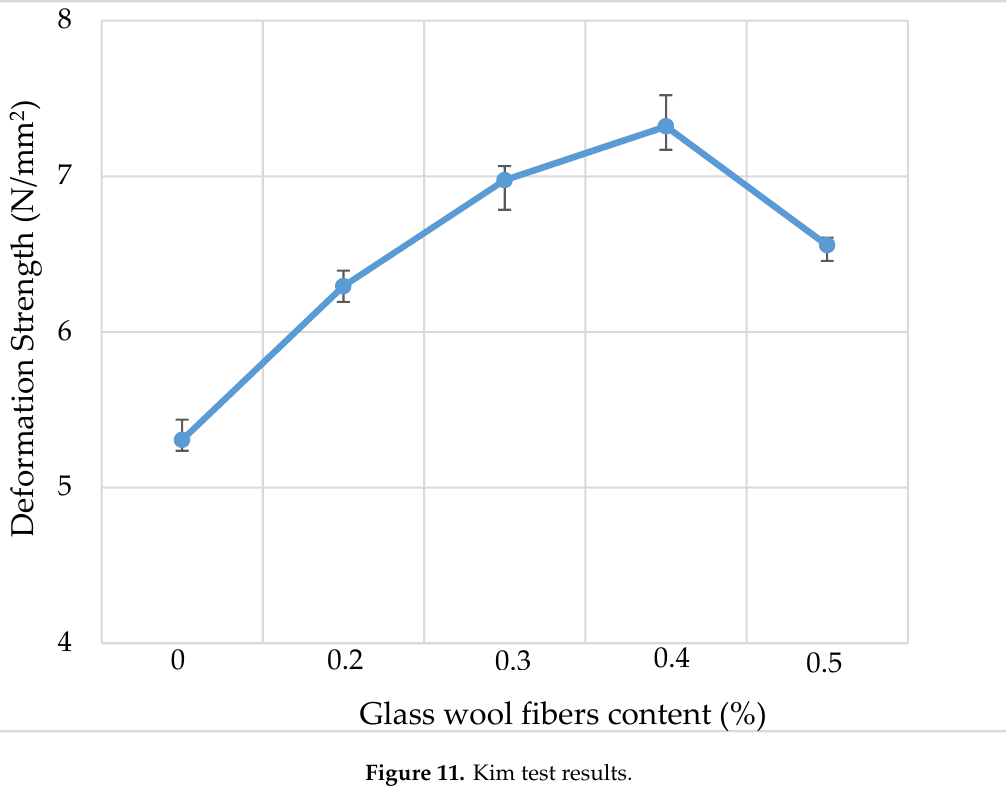
Figure 11. Kim test results.